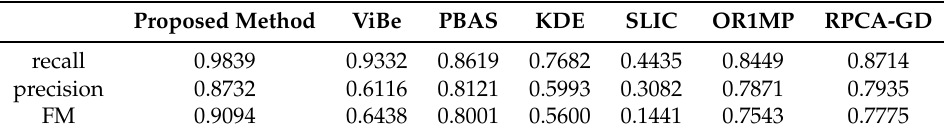
Table 6. Average evaluation metrics for all